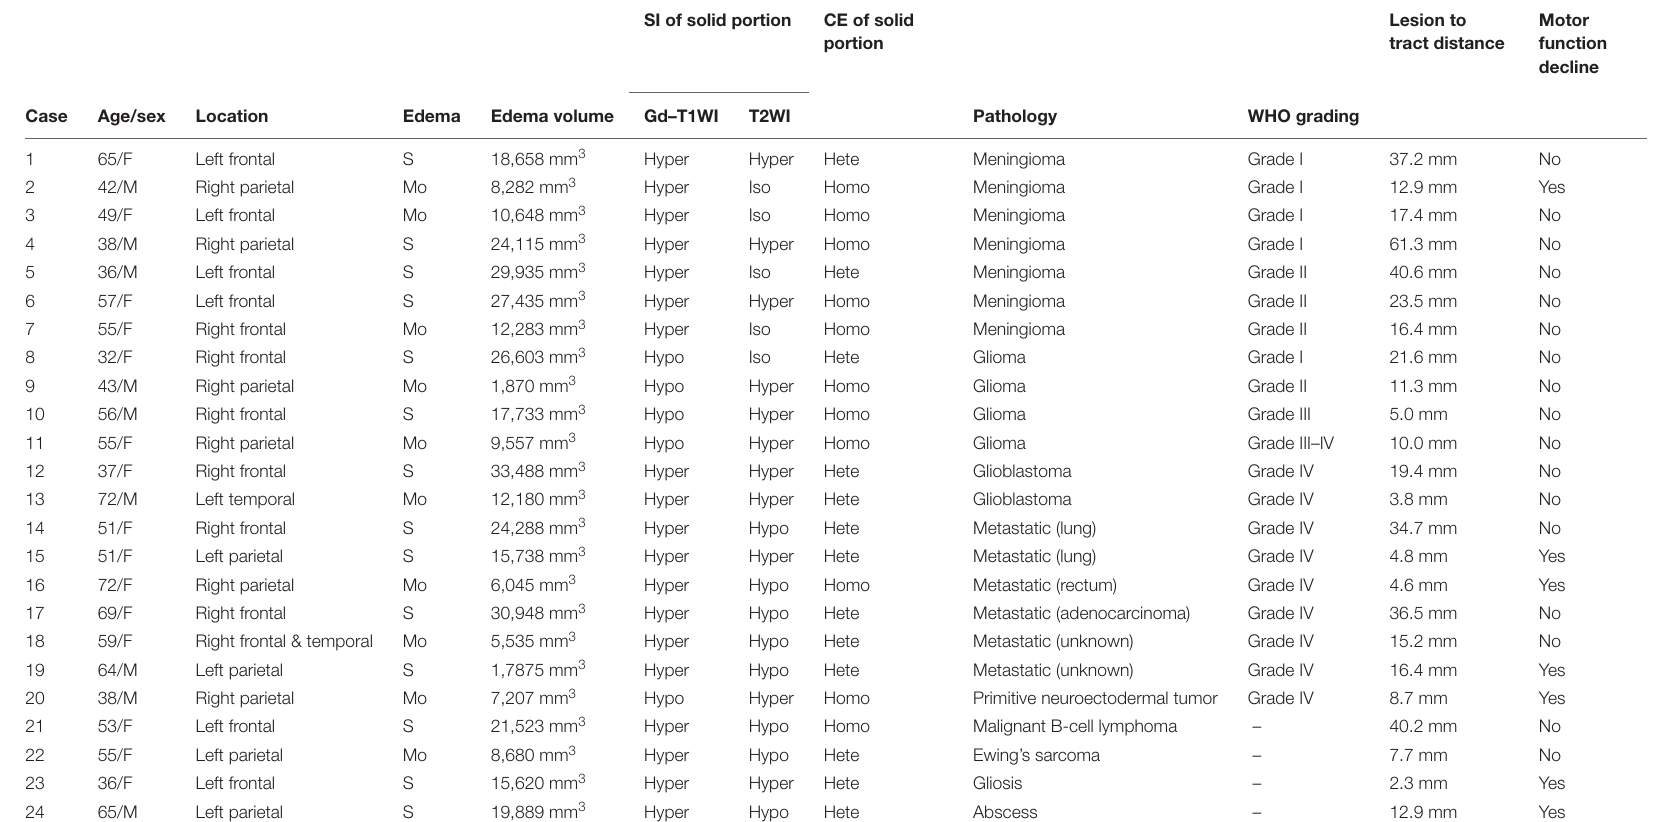
TABLE 1 | A summary of the clinical information, imaging features, and pathology of 24